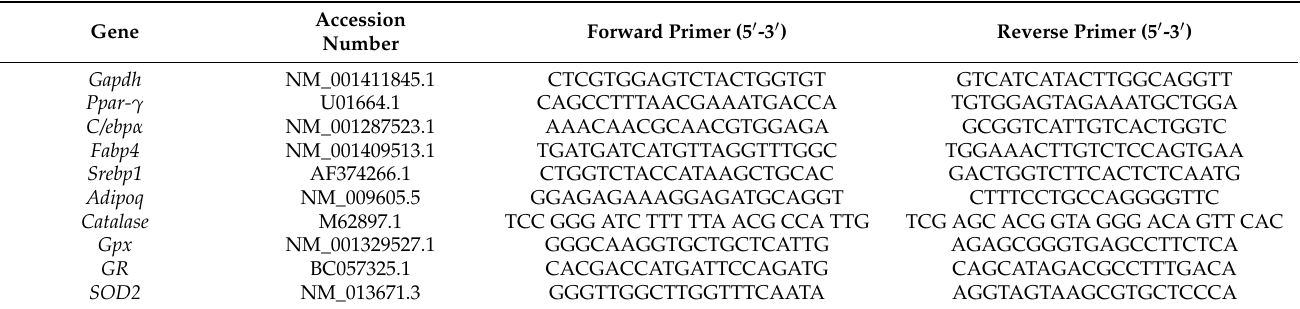
Table 1. Primer sequences used for quantitative RT-PCR